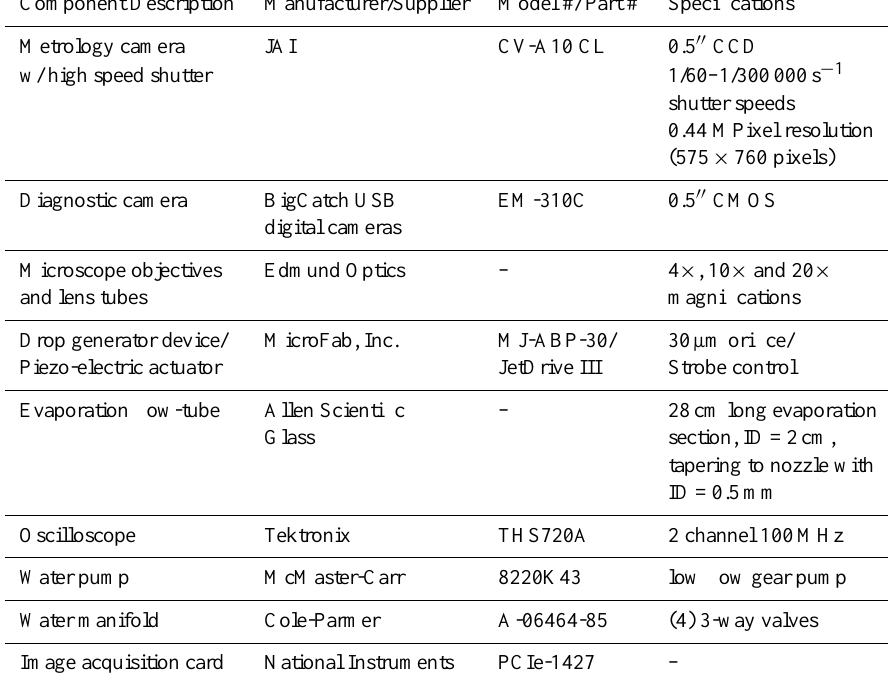
Table 2. Essential Components of the Water Droplet Calibration